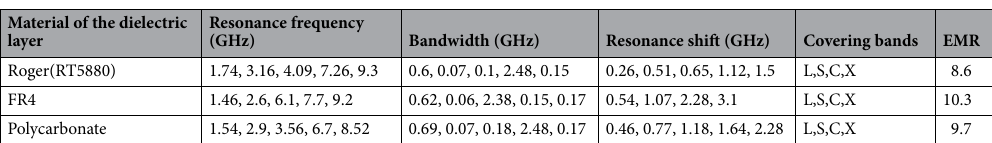
Table 3. Comparison of the effect of different dielectric layers over the